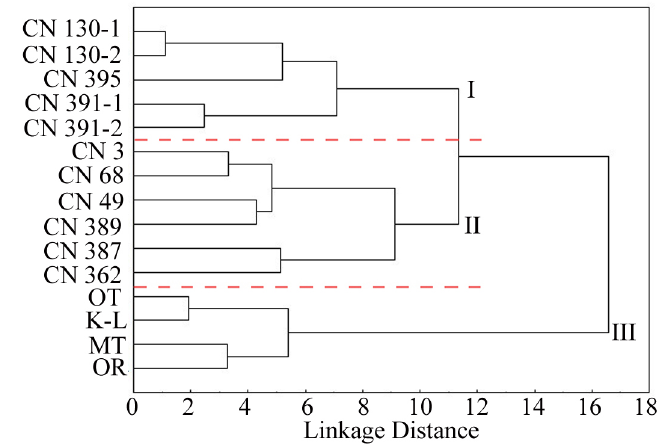
Figure 2. Dendrogram of cluster analysis of soils under vineyards of ancient times on in the Herakleian Peninsula and in selected areas of NW Crimea. I–III are groups of the vineyard